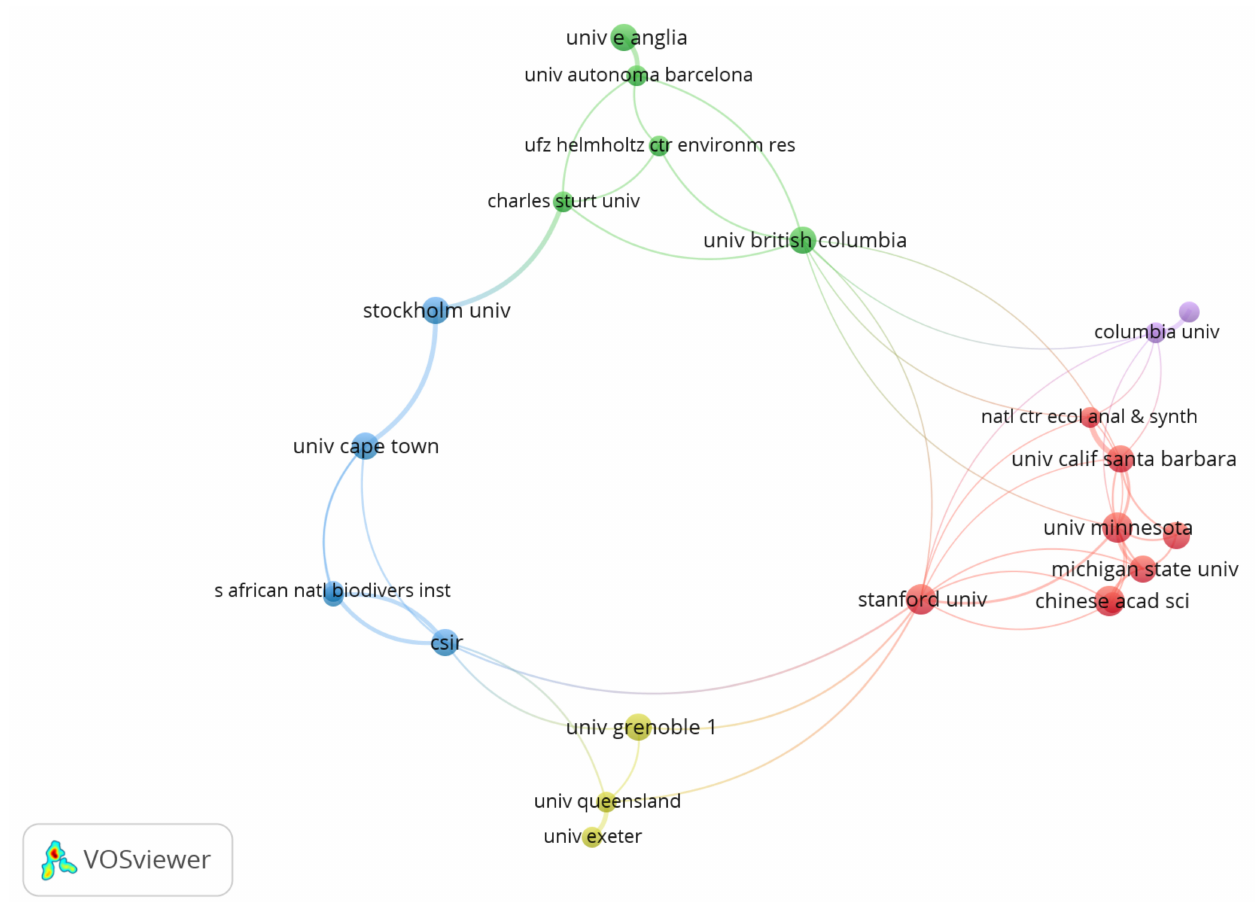
Figure 5. Co-authorship network of the top universities and institutions related to ecosystem services research in Web of Science Core Collection (WoSCC) database obtained by the highly cited journals from 2000 to 2020. Note: The threshold value = 2, applied for highly cited articles of 128, resulting in 23 institutions. The bubble size shows the total number of highly cited articles, the line thickness shows the linkage’s strength, and the color shows the